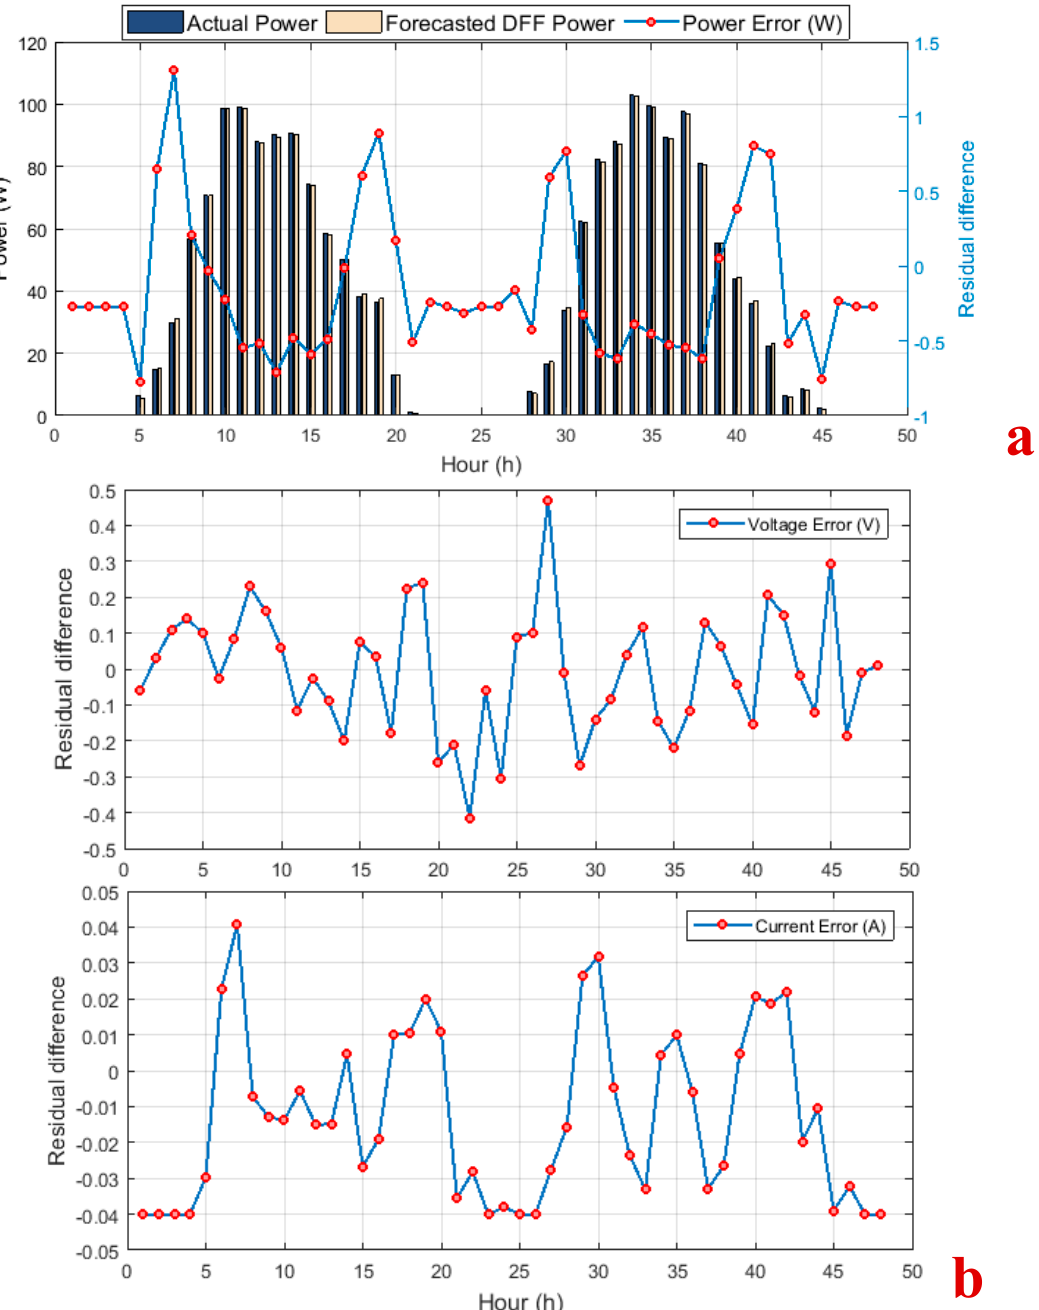
Figure 9. Real time comparison using the Astronergy-CHSM6610P PV panel ( a ) between the actual power and simulated DFF network ( b ) DFF voltage and current errors.